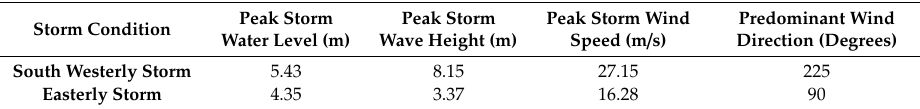
Table 3. Summary of storm boundary